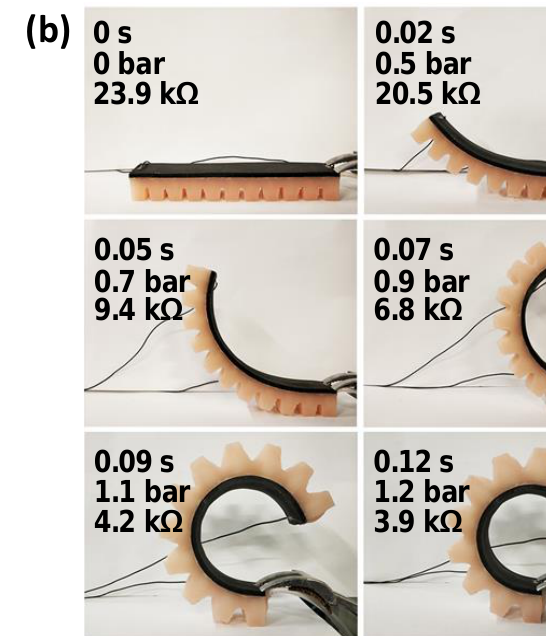
Figure 6. Cyclic response of (a) resistance–time (b) load force–displacement during cyclic testing of the sensing bottom layer.